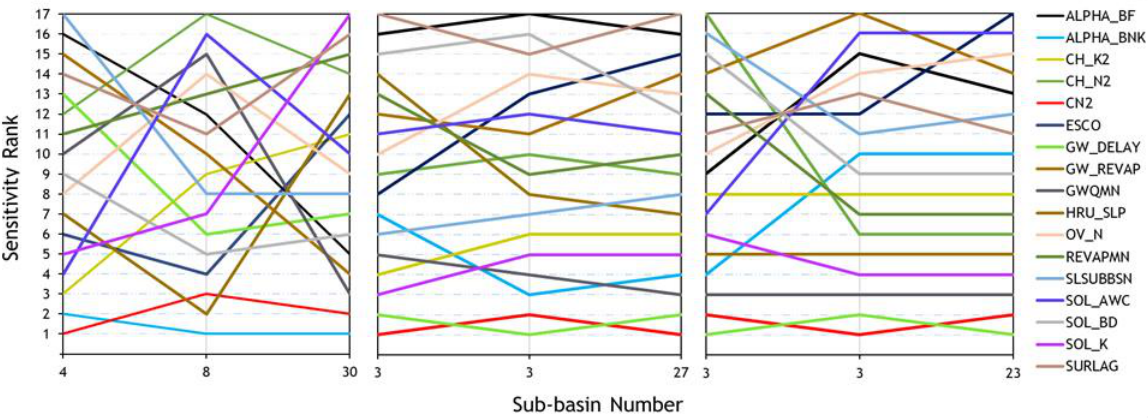
Figure 4. Sensitivity rank variation of the SWAT model’s flow parameters for the three subbasins of Abelti, Wabi, and Gecha, as determined by the t statistic, are shown on the left, center, and right, respectively. Table 2. SWAT model metric valuation over the calibration and validation phases.